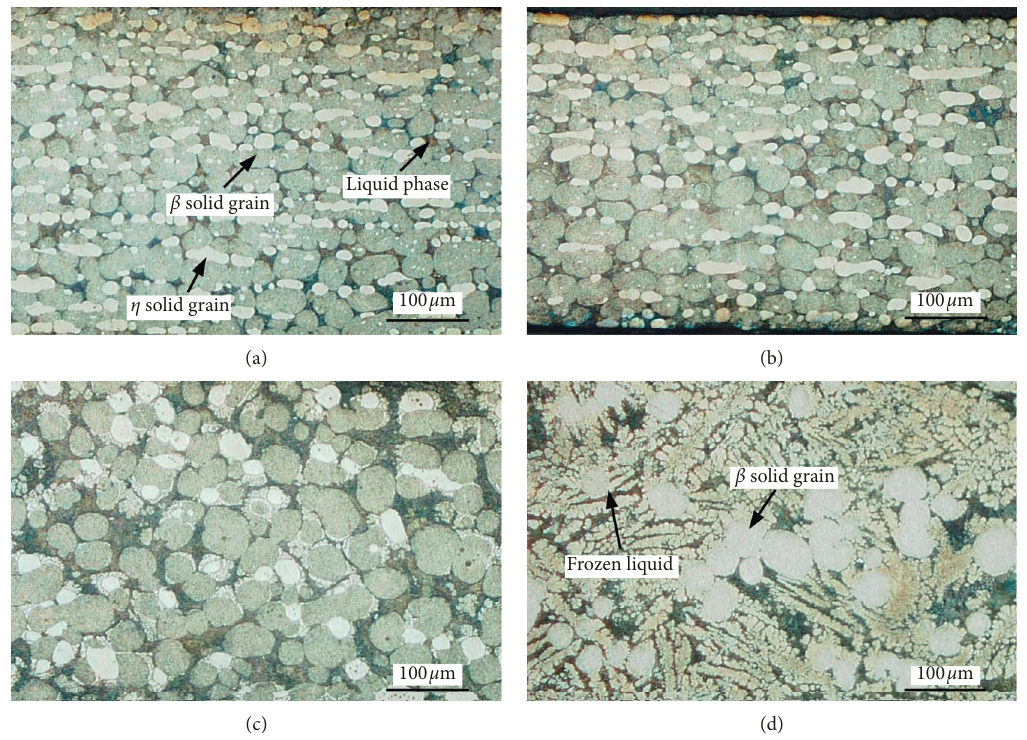
Figure 2: Microstructure of Zn-Al-Cu filler metal quenching at (a) 382 ° C, (b) 386 ° C, (c) 392 ° C, and (d) 402 °